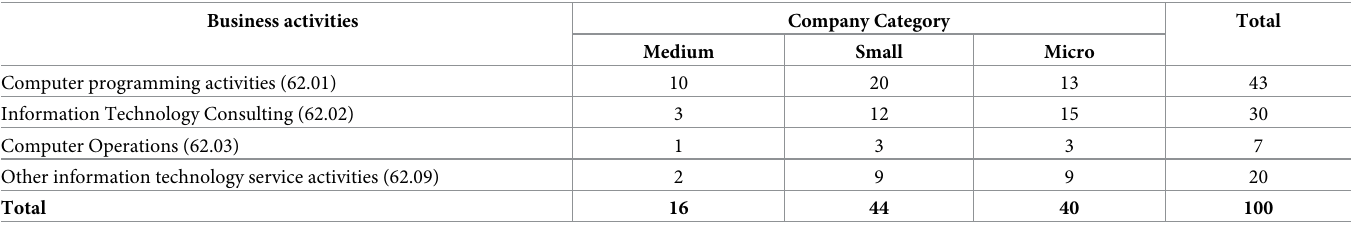
Table 3. Company classification according to activity